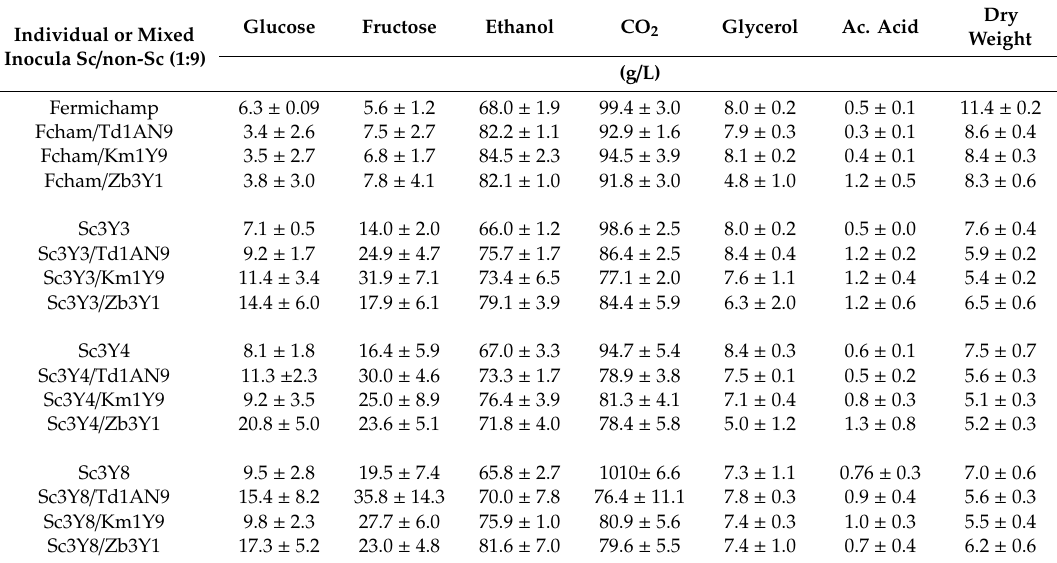
Table 5. Sugar consumption and primary metabolite production for the selected yeasts, fermenting individually, or as mixed inoculum in grape juice medium (103 g / L initial glucose and 105 g / L initial fructose), at 144